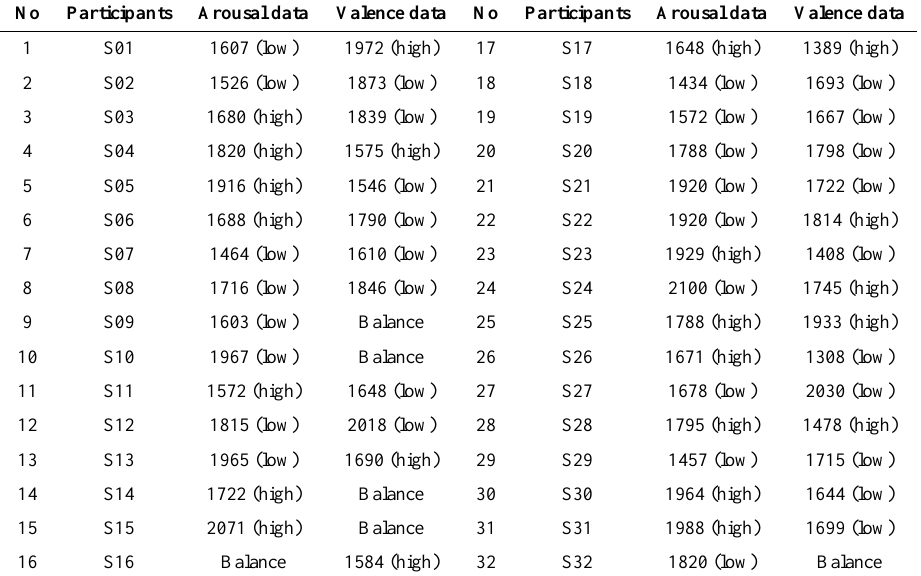
Table 3. Distribution of minor class in DEAP dataset after oversampling